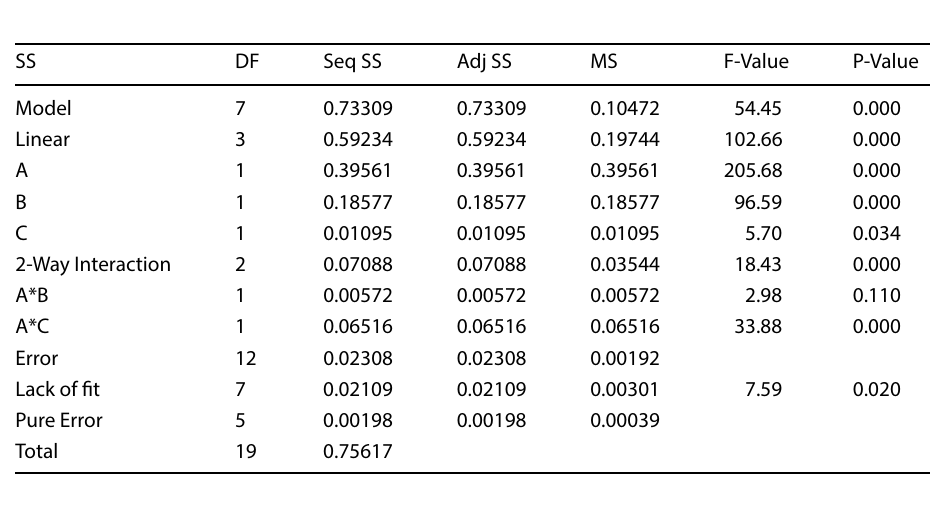
Table 7 ANOVA for Taper Angle of Al/B material